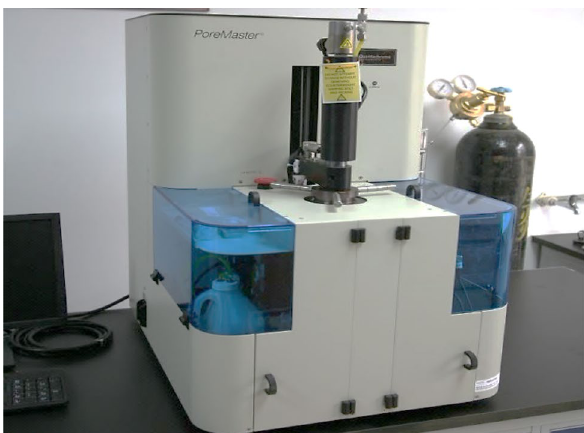
Fig. 1 PoreMaster 60 type of mercury pressure